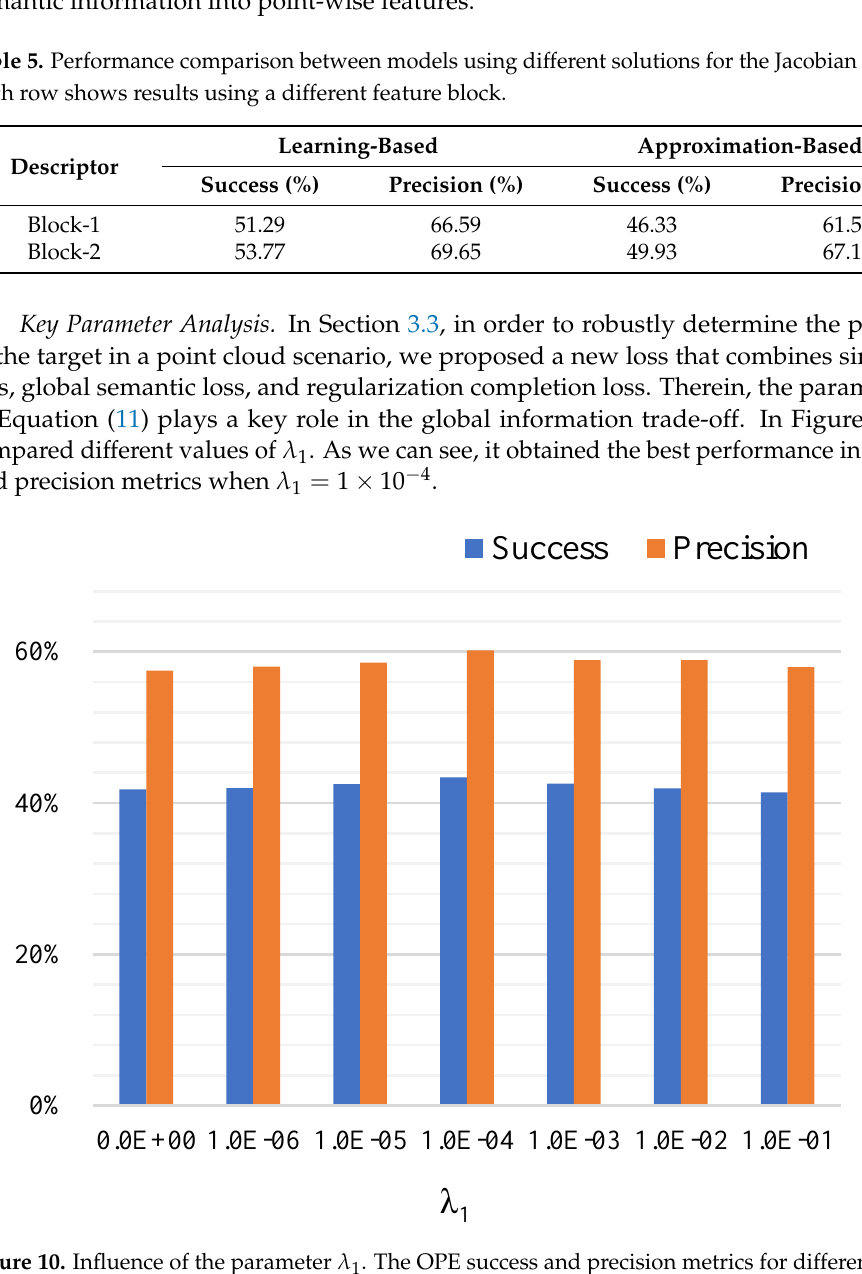
Figure 10. Influence of the parameter λ 1 . The OPE success and precision metrics for different values of λ 1 are